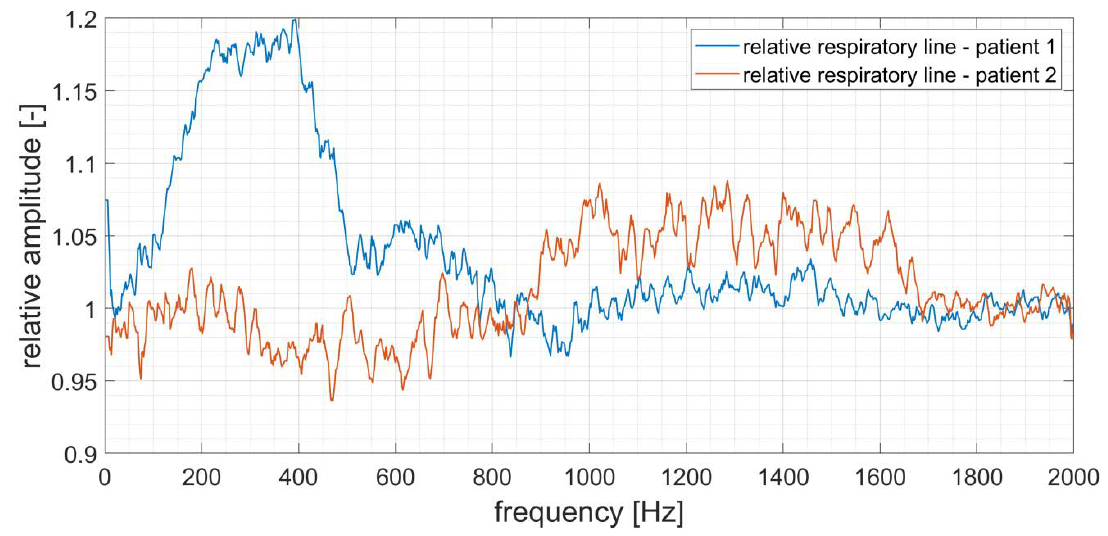
Figure 10. Comparing of two relative respiratory curves—healthy person (Patient No. 1) and patient with asthma (Patient No.